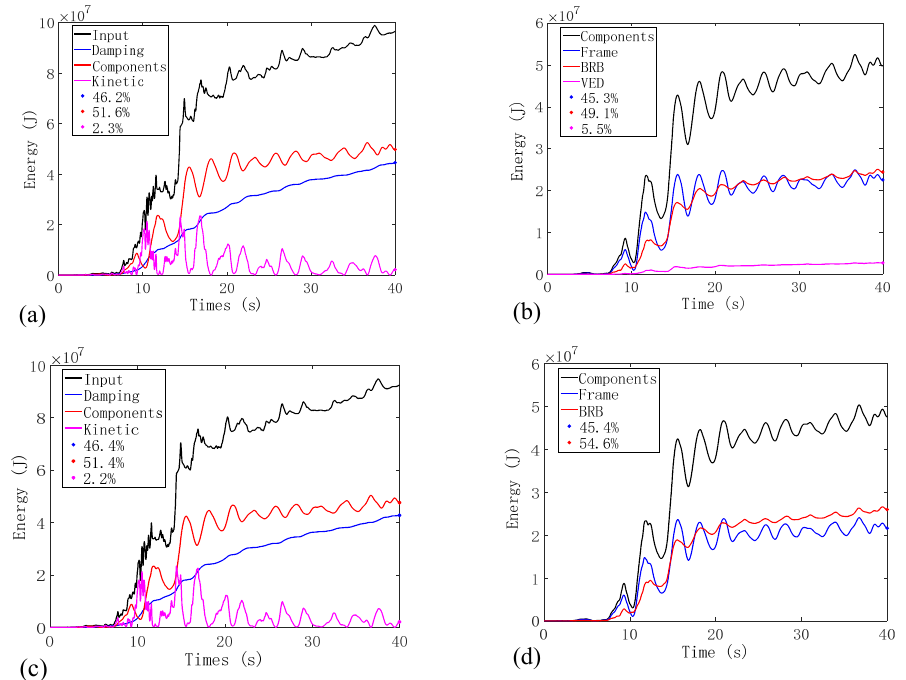
Figure 14. Seismic energy analysis (Loma Prieta case, PGA = 400 cm/s 2 ): ( a ) energy distribution (VBRB-BF); ( b ) energy absorbed by components (VBRB-BF); ( c ) energy distribution (BRB-BF); and ( d ) energy absorbed by components (BRB-BF).